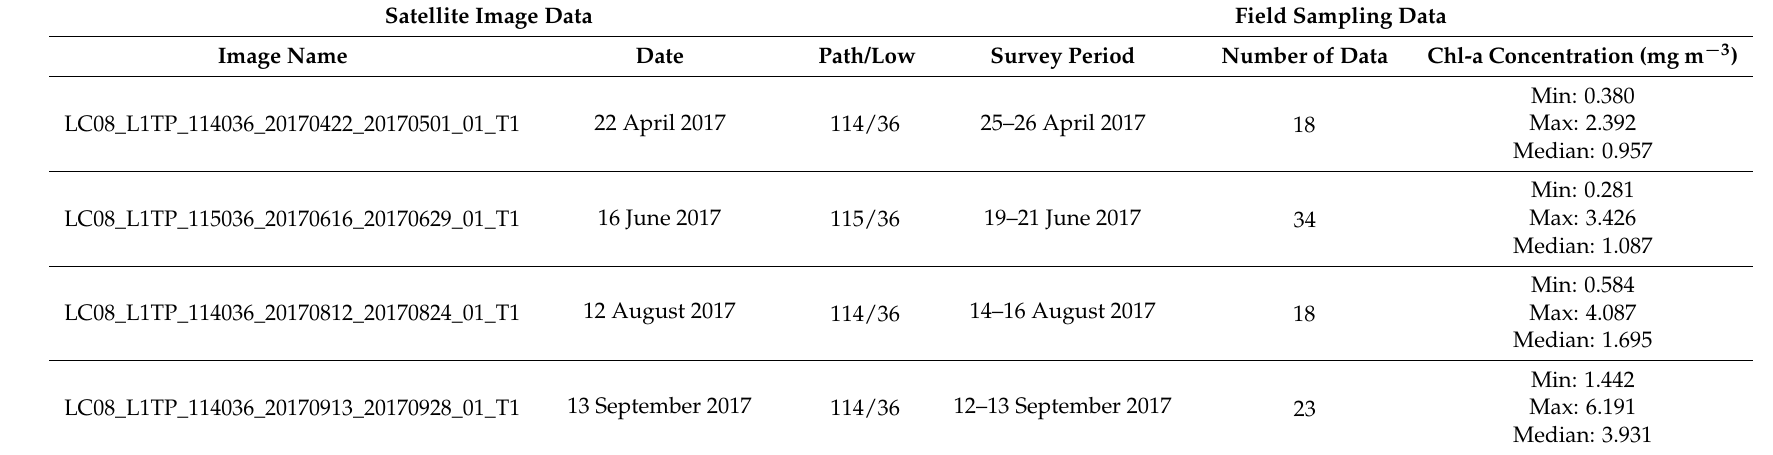
Table 2. Information regarding the satellite images, field sampling, and extracted band